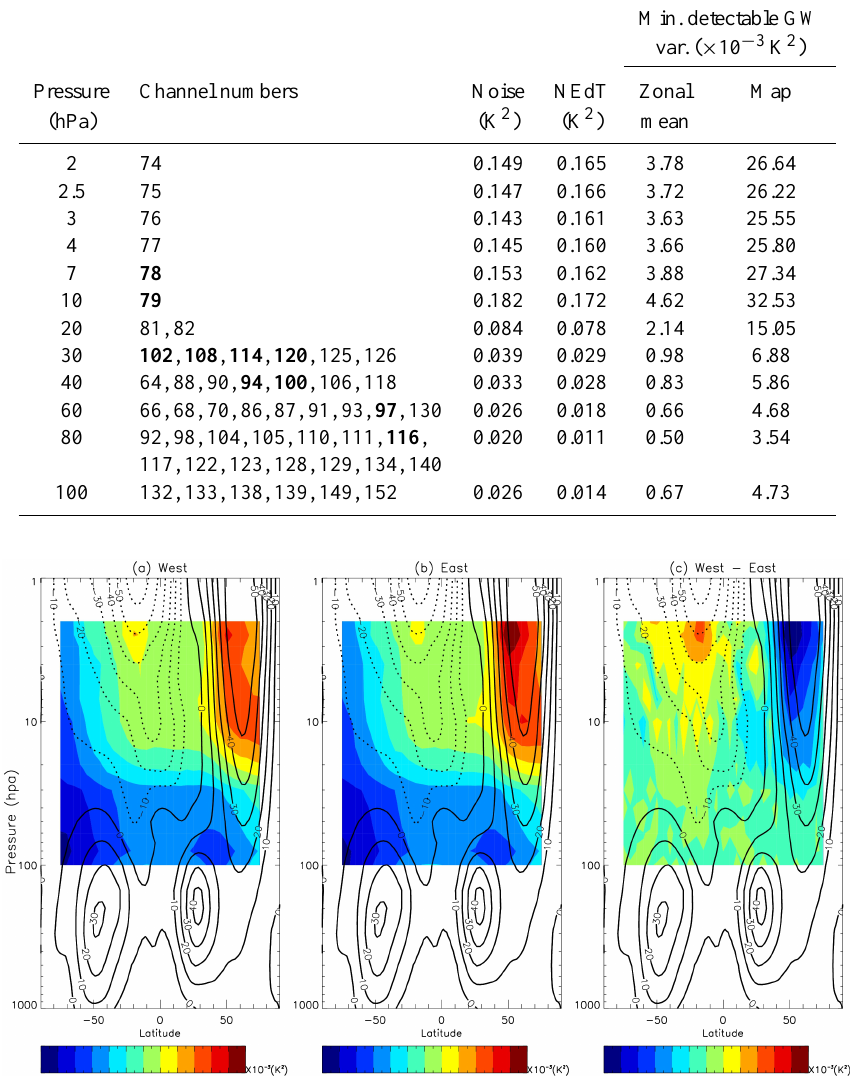
Table A2. A list of channel numbers, noise, NEdT, and minimum detectable GW variance at each pressure level. Bold numbers in the 2nd column are channels that are unpaired. See context for details.